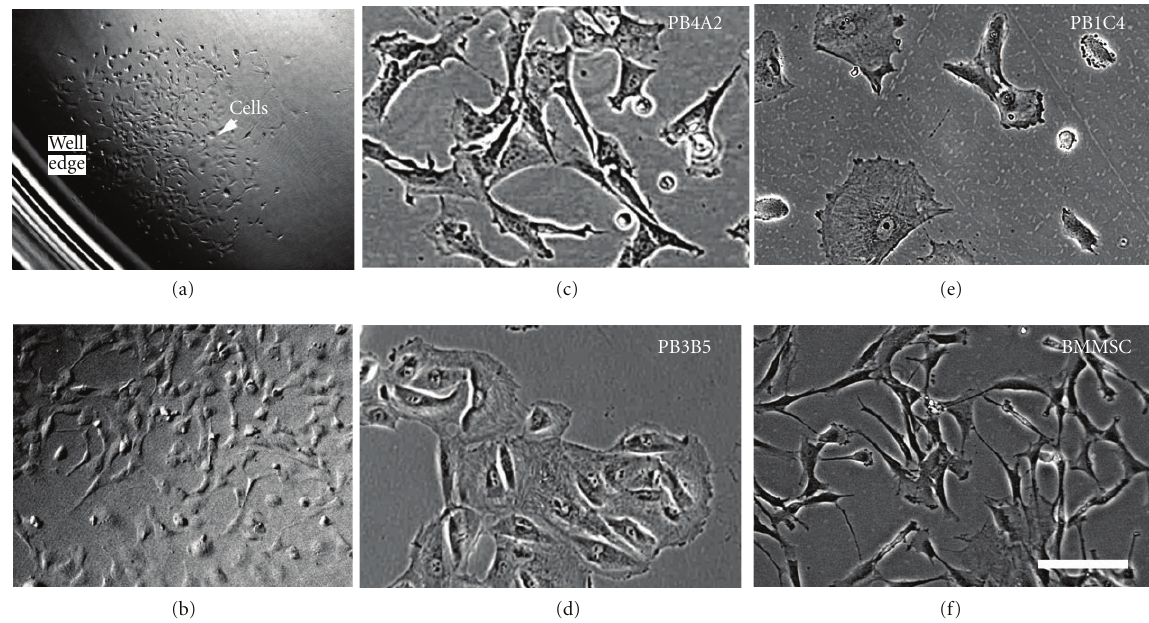
Figure 1: Clonal population of cells from amniocentesis samples. Uncultured amniocentesis samples were diluted into growth media and plated into 24-well tissue-culture-treated plates. (a) Low-magnification image shows an expanding clonal population in one well of 24-well plate as a spherical cluster that is located near the well edge. Arrow indicates cells. (b) Higher magnification (5x) of the same population shows apparently well isolated cells. Representative clonal populations are shown here with passage numbers (p) indicated: (c) PB4A2p4, (d) PB3A5p3, (e) PB1C4p11, and (f) BMMSCp5 control cells. Stromal (c) PB4A2p4 and (e) PB1C4p11 cell populations resemble (f) BMMSCp4 cells, showing irregular cell boundaries while (d) PB3B5 epithelial cells were typically spheroid and often found in clusters with closely apposed boundaries. Scale bar, 100 microns. Magnification is identical in (c), (d), (e), and